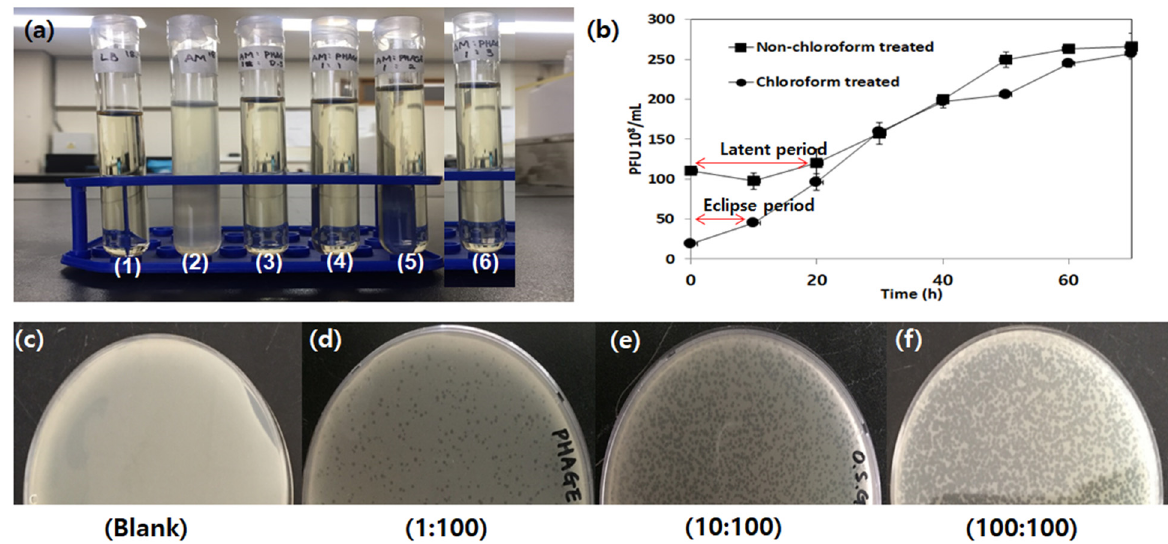
Figure 4. ( a ) Invitro bacteriolytic activity of phage 1. Negative control (LB broth), 2. LB broth with Aeromonas (10 8 CFU/mL) 3. (0.5:1), 4. (1:100), 5. (10:100), 6. (100:100) phage–host ratio